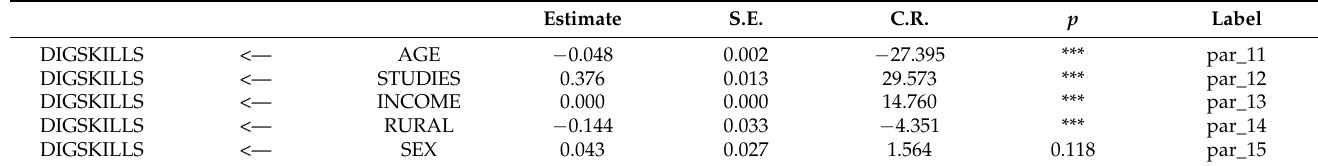
Table A19. Regression Weights: (Group number 1-Default model).